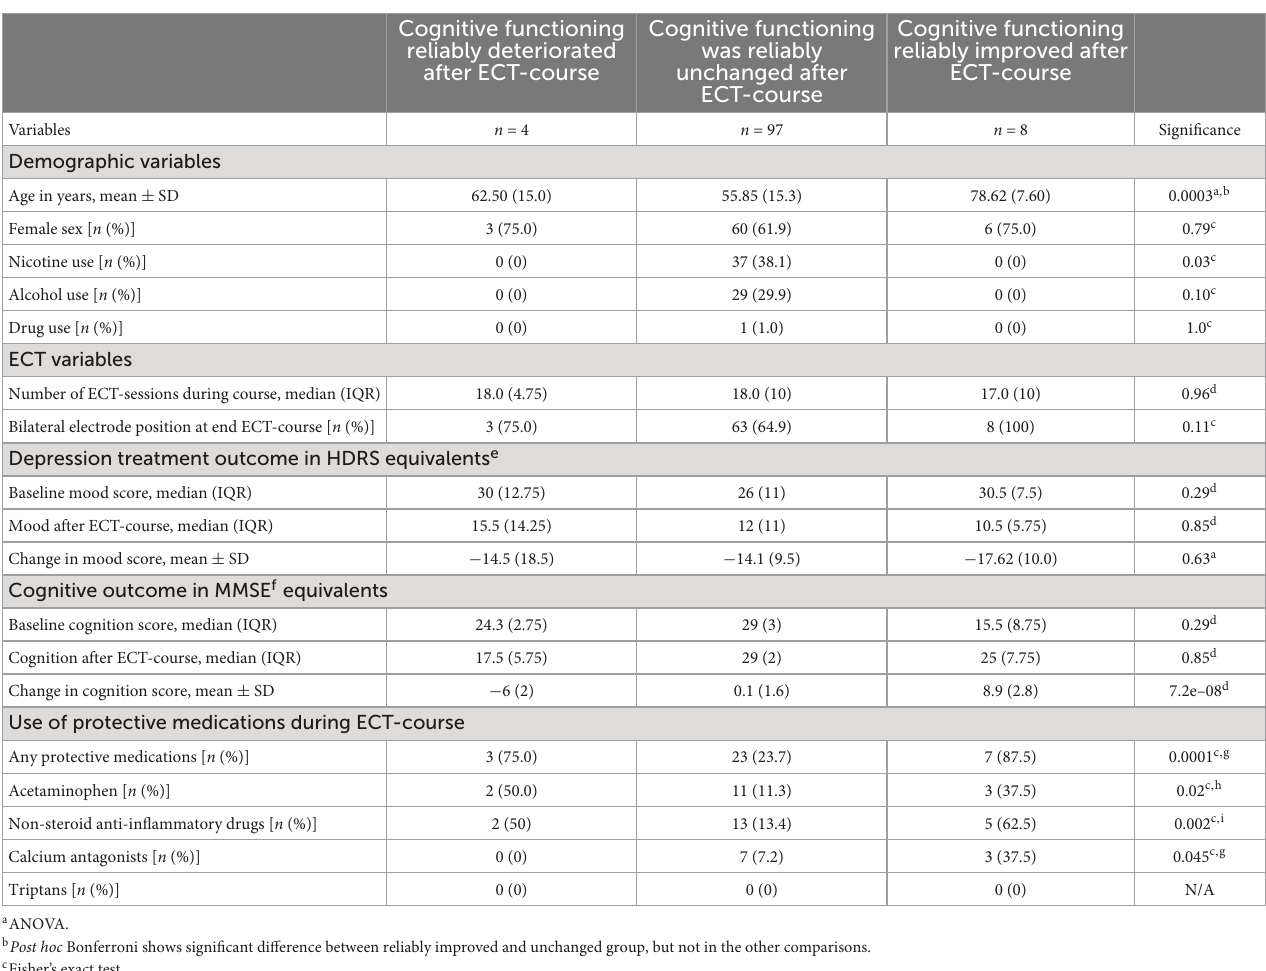
TABLE 3 Univariate statistics of patient-, treatment-, and outcome characteristics in 109 patients, who reliably cognitive deteriorated ( n = 4), reliably cognitive unchanged ( n = 97), and reliably cognitive improved ( n = 8) after electroconvulsive therapy (ECT).